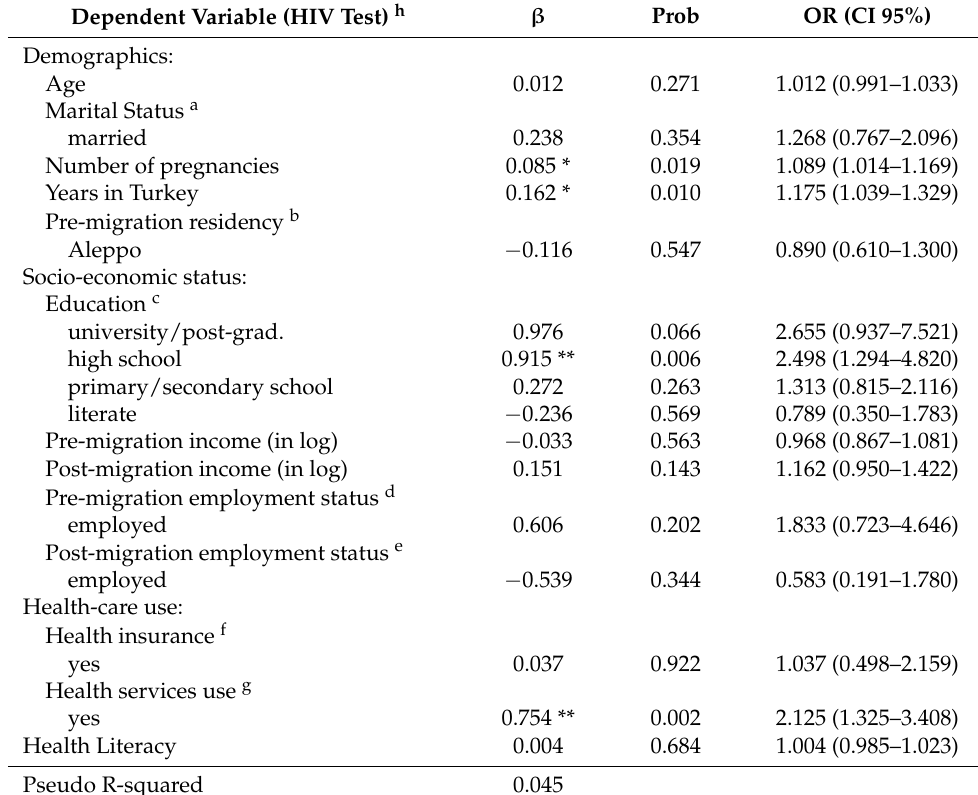
Table 4. Logistic regression